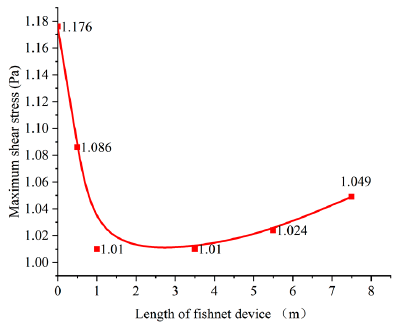
Figure 14. Influence of the length of the fishnet device on the maximum shear stress.